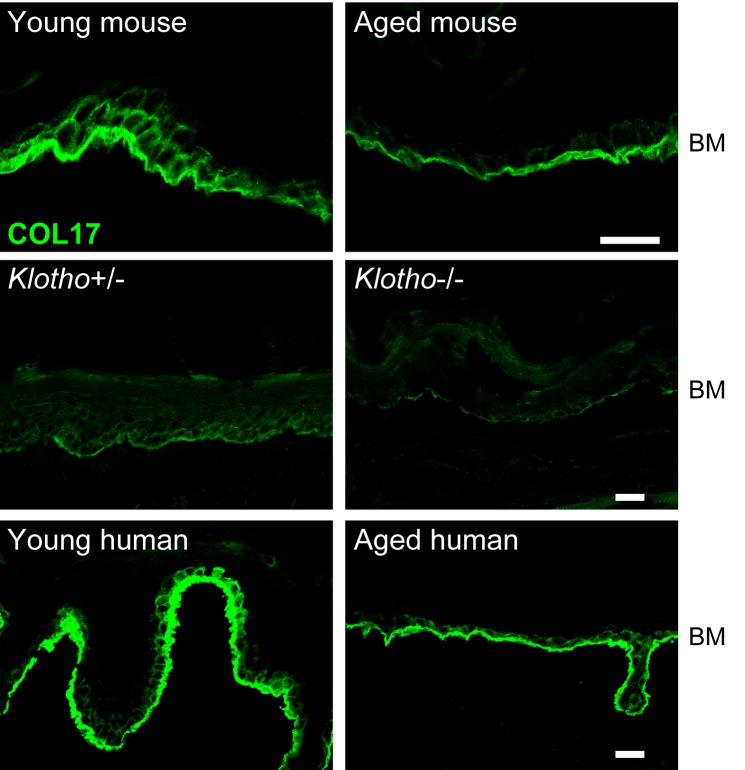
Intracellular COL17 labeling of the IFE from young/aged WT mice and human individuals.Antibodies against the intracellular portions of COL17, which recognize the full-length protein, were used. The antibodies do not react with the shed ectodomain of COL17. Scale bar: 20 μm. Samples from Klotho+/− and Klotho−/− littermates were obtained at the age of 6 weeks. Representative images from three samples.